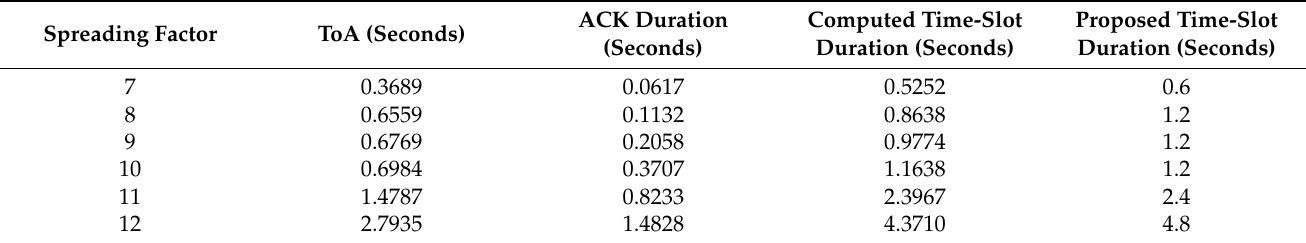
Table 2. Maximum time on air and time-slot duration for TSSFH.